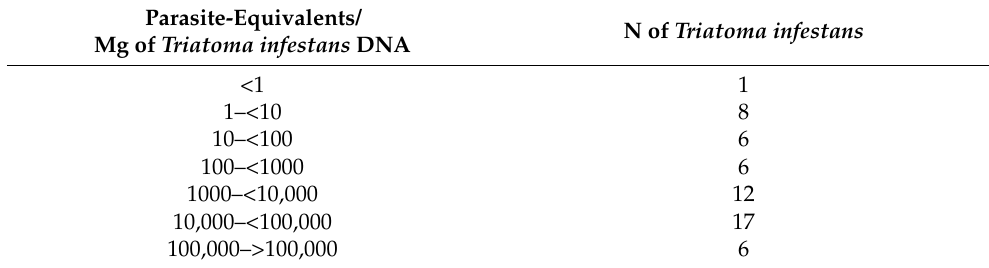
Table 1. Number of Triatoma infestans infected by Trypanosoma cruzi per parasite load range.